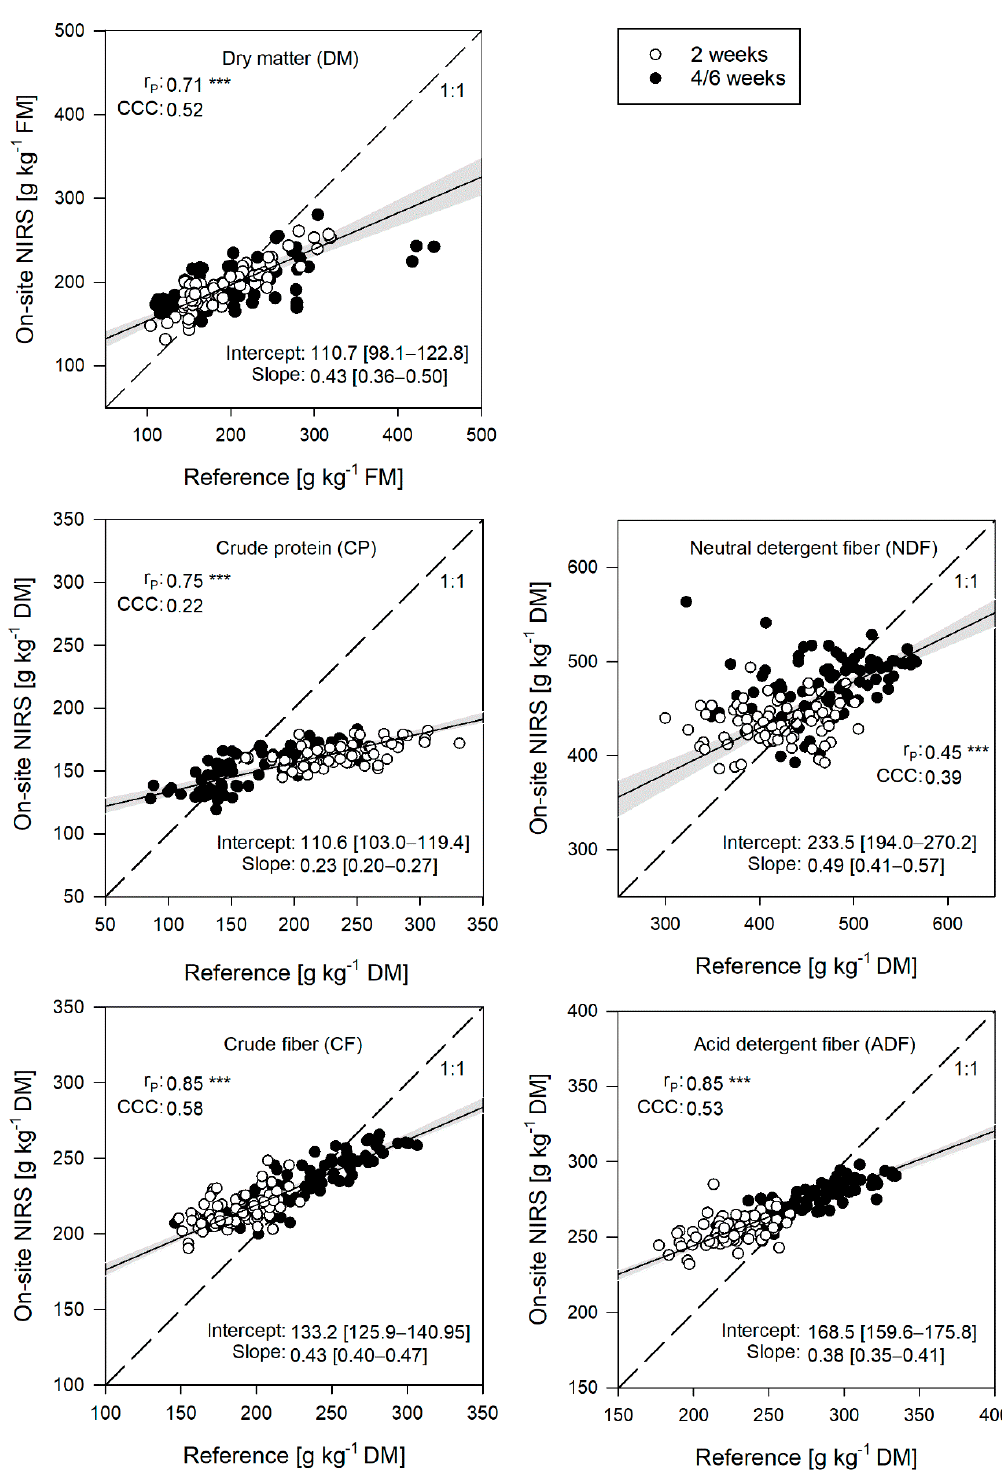
Figure 5. On-site NIRS versus reference measurements ( n = 162) of herbage quality parameters. The dashed line is the line of identity (1:1). The open and filled dots represent the two growth stages of the plants: two weeks of growth and four to six weeks of growth. Passing–Bablok regression is shown as a solid line with a 95% confidence band. Intercept and slope with 95% confidence intervals are indicated. The values of Pearson’s correlation coefficient (r P ) and Lin’s concordance correlation coefficient (CCC) are also given. Significance codes: *** ≤ 0.001, ** ≤ 0.01, * ≤ 0.05.